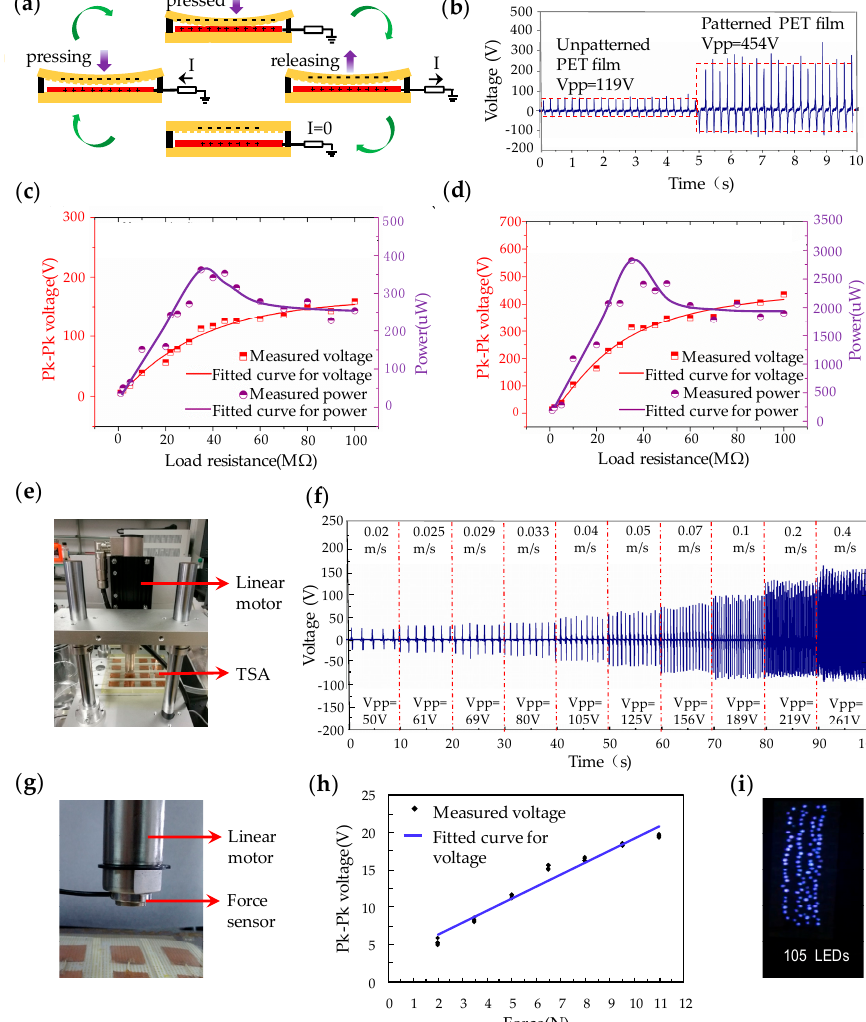
Figure 2. ( a ) Operating mechanism of the triboelectric TSA; ( b ) Output voltage of the TSA by using unpatterned and patterned PET; Voltage and power transferred to different load resistors of the TSA by using ( c ) unpatterned and ( d ) patterned PET; ( e ) Measurement setup for studying the sensing performance of the TSA; ( f ) Output voltage generated by the TSA at different speeds of the external force; ( g ) Experimental setup to measure the pressure applied on the TSA; ( h ) Peak-to-peak voltage generated by the TSA at different applied pressures; ( i ) Each patterned triboelectric sensing unit can simultaneously light up 105 LEDs by finger tapping.